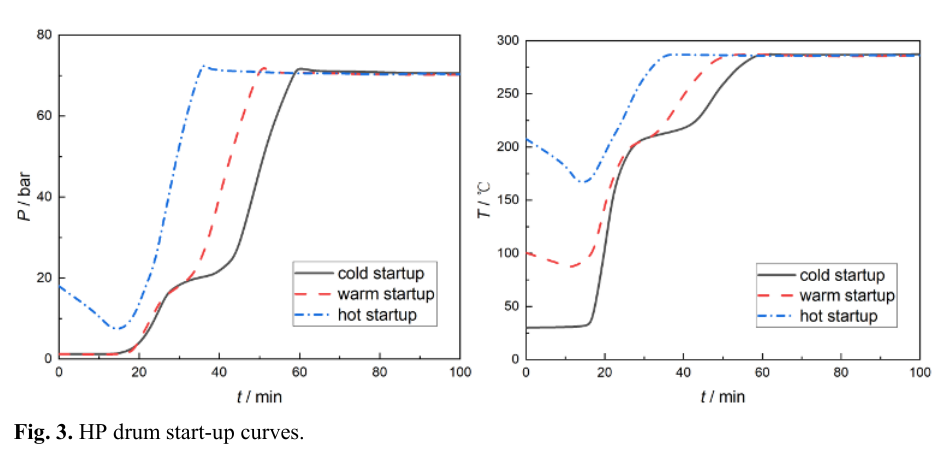
Fig. 3. HP drum start-up curves.